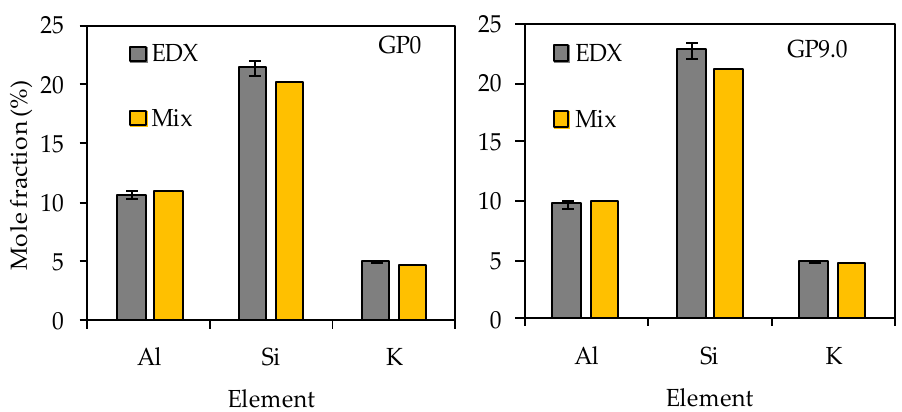
Figure 17. Silicon, aluminum and potassium mole fractions of geopolymers GP0 and GP9.0 before exposure to sulfuric acid. Calculated mole fractions of geopolymer composition (Mix) and mole fractions determined by EDX elemental mappings (EDX).